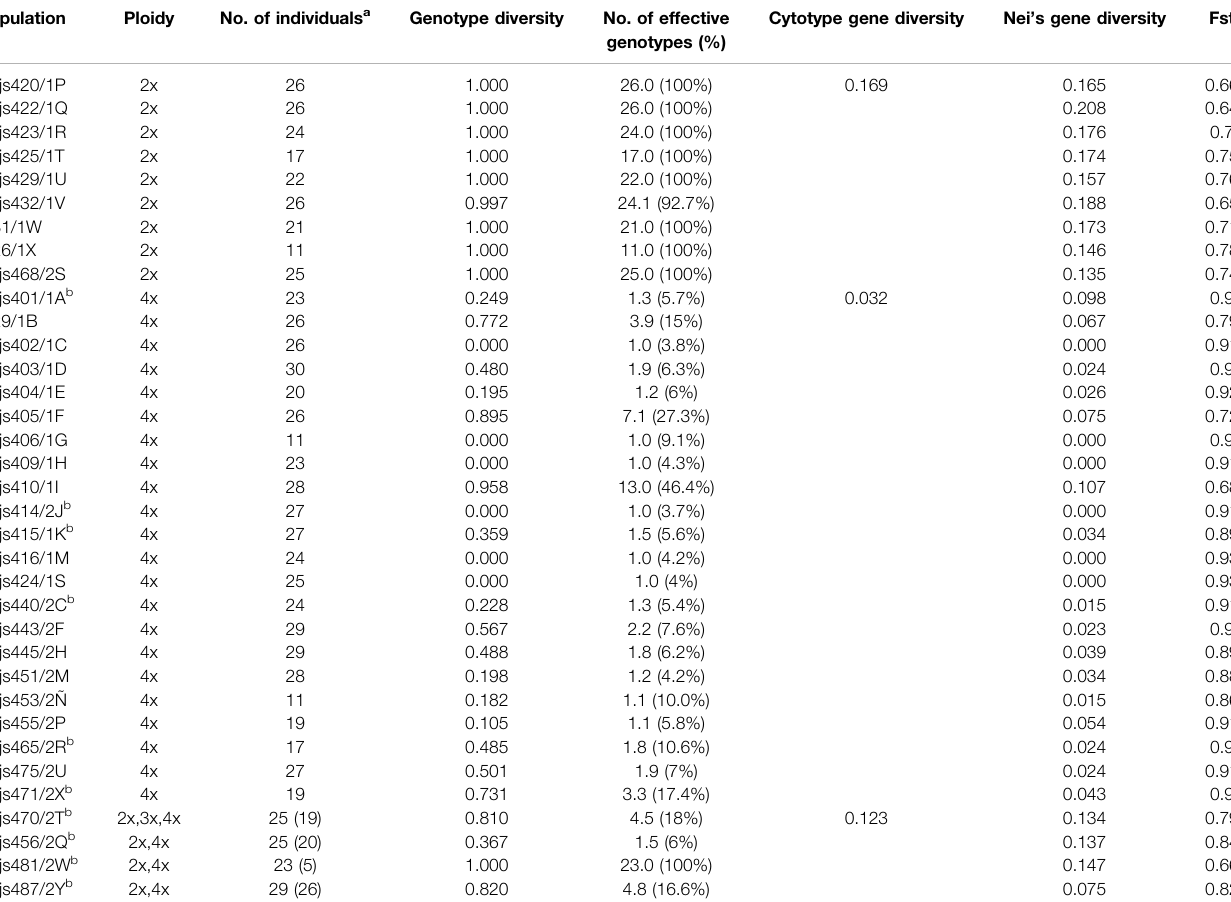
TABLE 1 | Populations of P. intermedium with different ploidy levels, assessed in the present study for genetic variation. Nei ’ s gene diversity, genotype diversity, and the number of effective genotypes were calculated as in Nei ’ s (1987) with ampli fi ed fragment length polymorphism (AFLP) markers. The cytotype gene diversity was calculated for each population and averaged to diploid, tetraploid, and mixed-ploidy populations.